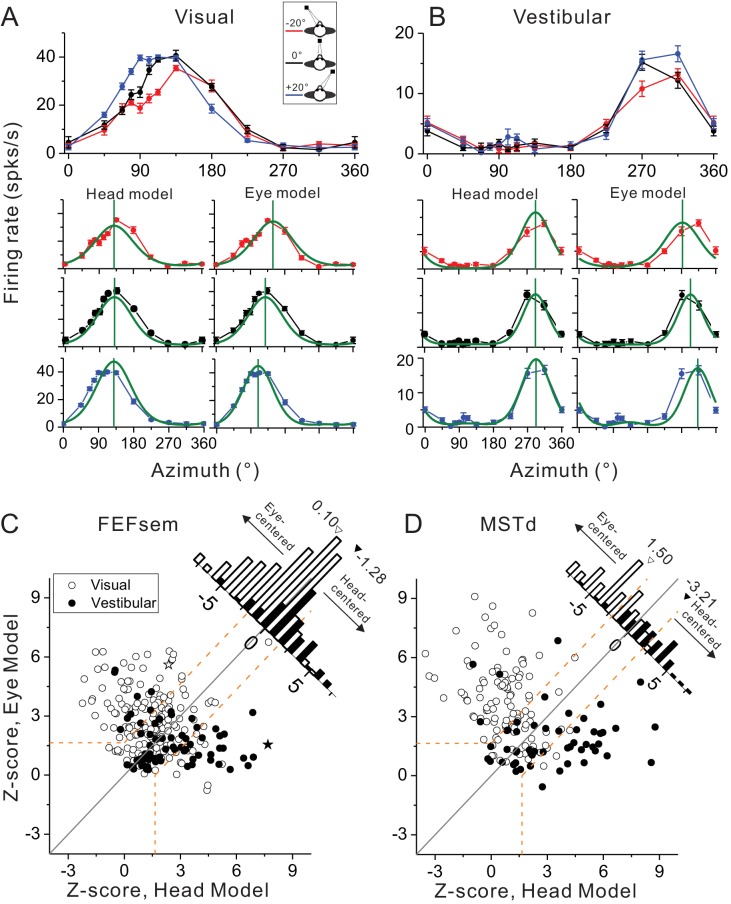
Spatial reference frames as assessed by head- and eye-centered model fittings.(A, B) Heading tuning functions from an example neuron in the visual (A) and vestibular (B) condition. Red, black and blue curves represent eccentric fixation at −20°, 0° and 20°, respectively. Superimposed green curves depict the fitting of eye-centered or head-centered models. Vertical green lines are the prefer directions of the fitting curves. (C, D) Eye- and head-centered model correlation coefficients (Z-transformed) in FEFsem (C) and MSTd (D). Filled symbols: vestibular; Open symbols: visual. Significance regions are based on the difference between eye- and head-centered Z scores corresponding to p<0.05 (top left, eye centered; bottom right, head centered; central diagonal region, intermediate). The two asterisks, one open and one filled, represent the example cell in (A) and (B), respectively. Diagonal histograms represent distributions of differences between Z-scores for each pair of models (eye- minus head-centered). Arrowheads indicate the mean values of each distribution. Filled bars: vestibular; Open bars: visual.